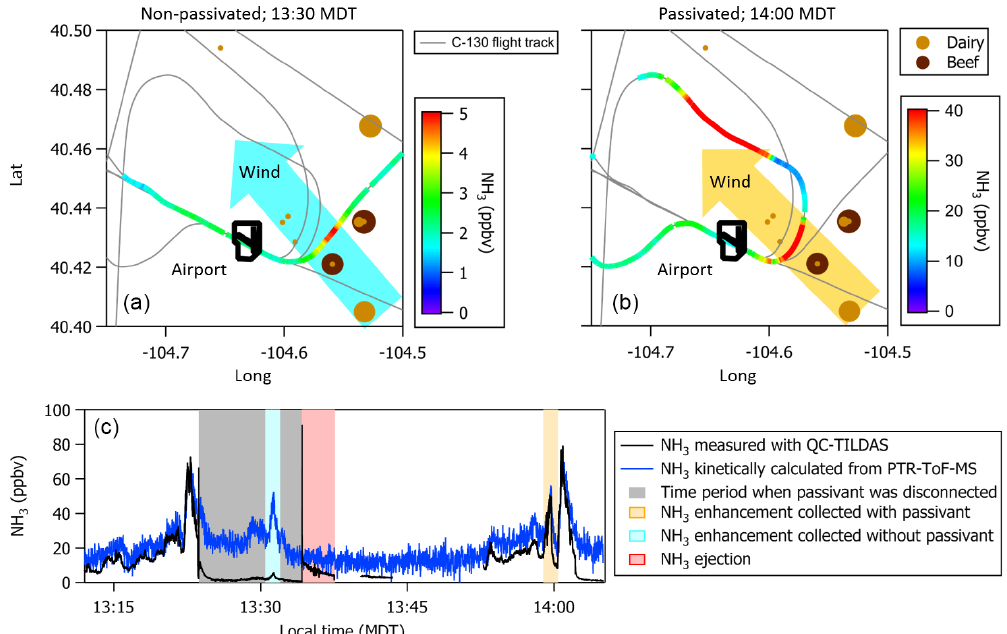
Figure 8. (a, b) C-130 flight tracks and the average wind direction during the 29 September 2017 test flight. Colored segments of the flight tracks highlight enhancements in NH 3 measured downwind of concentrated animal operations (brown symbols sized by head of cattle) located southeast of Greeley-Weld County Airport. (c) Time series of 1Hz NH 3 mixing ratios measured using the contaminated QC-TILDAS instrument and kinetically calculated from a raw instrument signal obtained simultaneously aboard the C-130 aircraft by a Proton Transfer Reaction Time-of-Flight Mass Spectrometer (PTR-ToF-MS). Portions of the flight when the contaminated QC-TILDAS was non-passivated (at 13:30MDT) and passivated (at 14:00MDT) are highlighted by colored shaded areas in the time series. Passivant was disconnected from the QC-TILDAS instrument system between 13:23 and 13:34MDT (as indicated by the gray shaded area); NH 3 ejection is observed when passivant is re-added to the system (red shaded